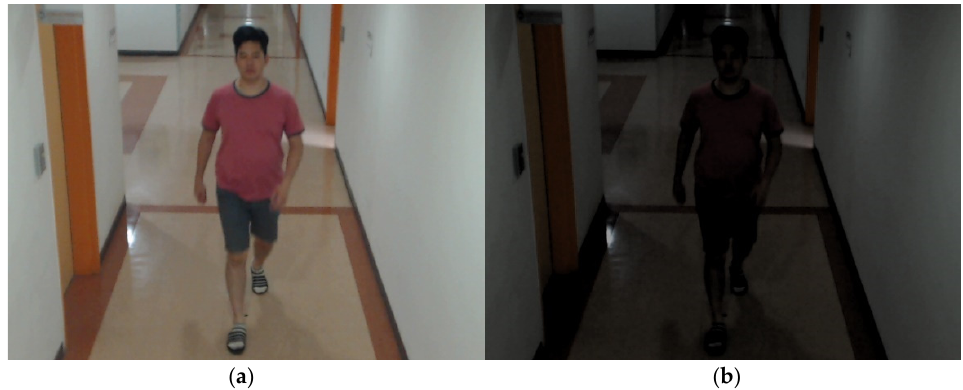
Figure 2. Examples of ( a ) normal and ( b ) low-illumination images captured by an indoor surveil- lance